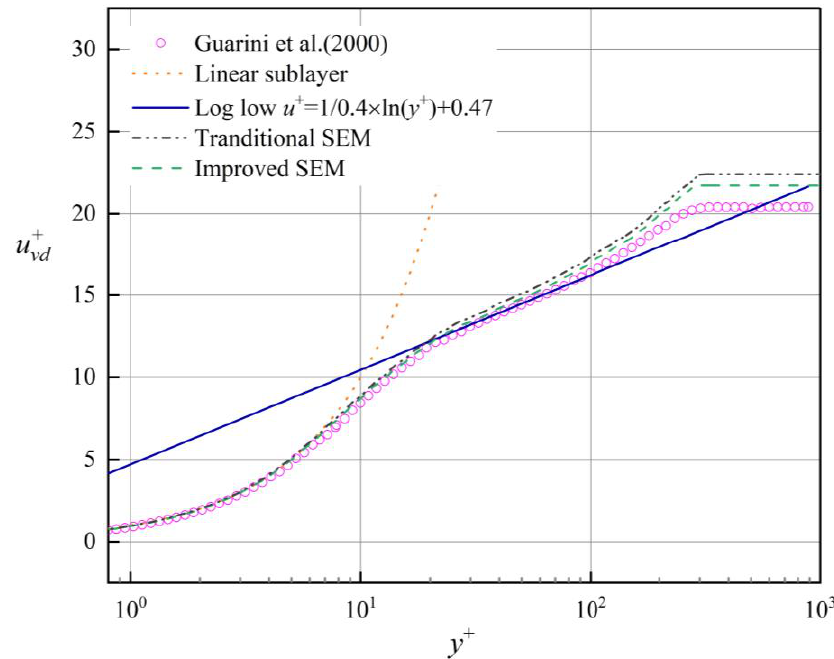
Figure 11. Mean velocity distributions at x = 12 δ